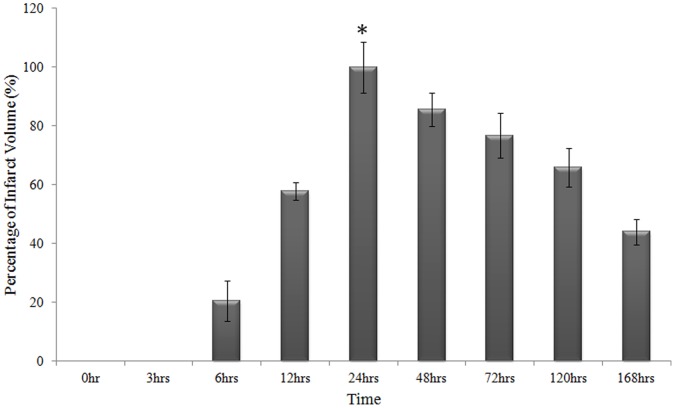
Histogram on percentage of infarct volume at 0 hrs, 3 hrs, 6 hrs, 12 hrs, 24 hrs, 48 hrs, 72 hrs, 120 hrs and 168 hrs after MCAo.Brain slices were stained with TTC prior to the measurement of the infarct size. Infarct volume at 24 hrs post occlusion is significantly the maximum (350±30 mm3) than that of other time points (p<0.05), thus the infarct volume at 24 hrs is set as 100%.